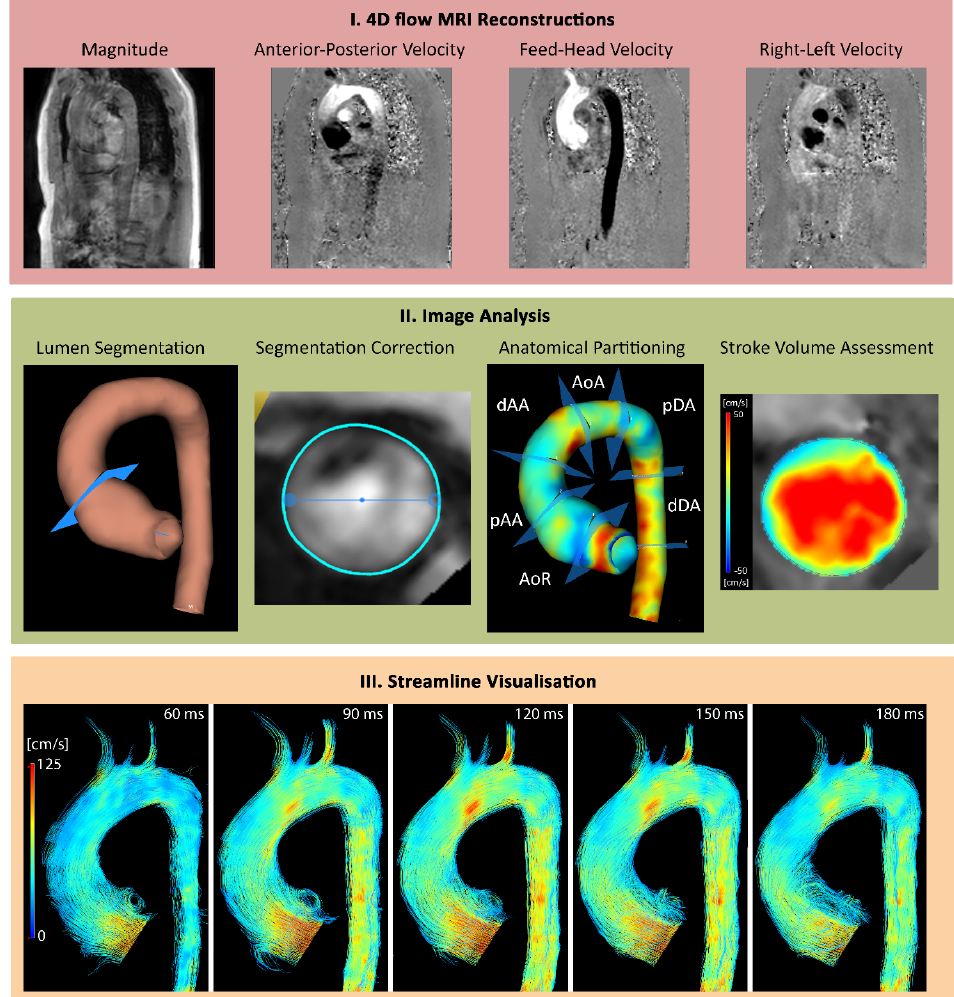
Figure 2. 4D flow MRI visualization using CAAS MR Solutions v.5.2.1. Example of a patient (male, 45 years old) with aortic root aneurysm with a diameter of 52 mm. ( I ) 4D flow MRI reconstructions. ( II ) Image analysis including the lumen segmentation, the manual segmentation correction, anatomical partitioning visualized on the wall shear stress maps, and stroke volume assessment. ( III ) Streamline visualization of the 4D flow MRI at the 5 systolic phases (60, 90, 120, 150, and 180 ms). Abbrevations: AoR—aortic root, pAA—proximal ascending aorta, dAA—distal ascending